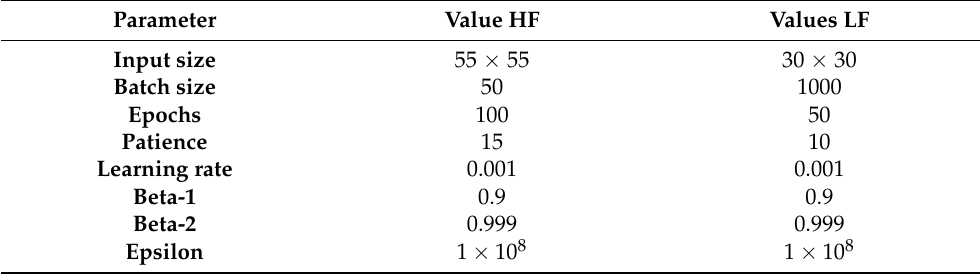
Table 2. Hyper-parameter values of the CNN model and parameters of the Adam optimizer. HF and LF are the parameters for using high-frequency and low-frequency data, respectively.